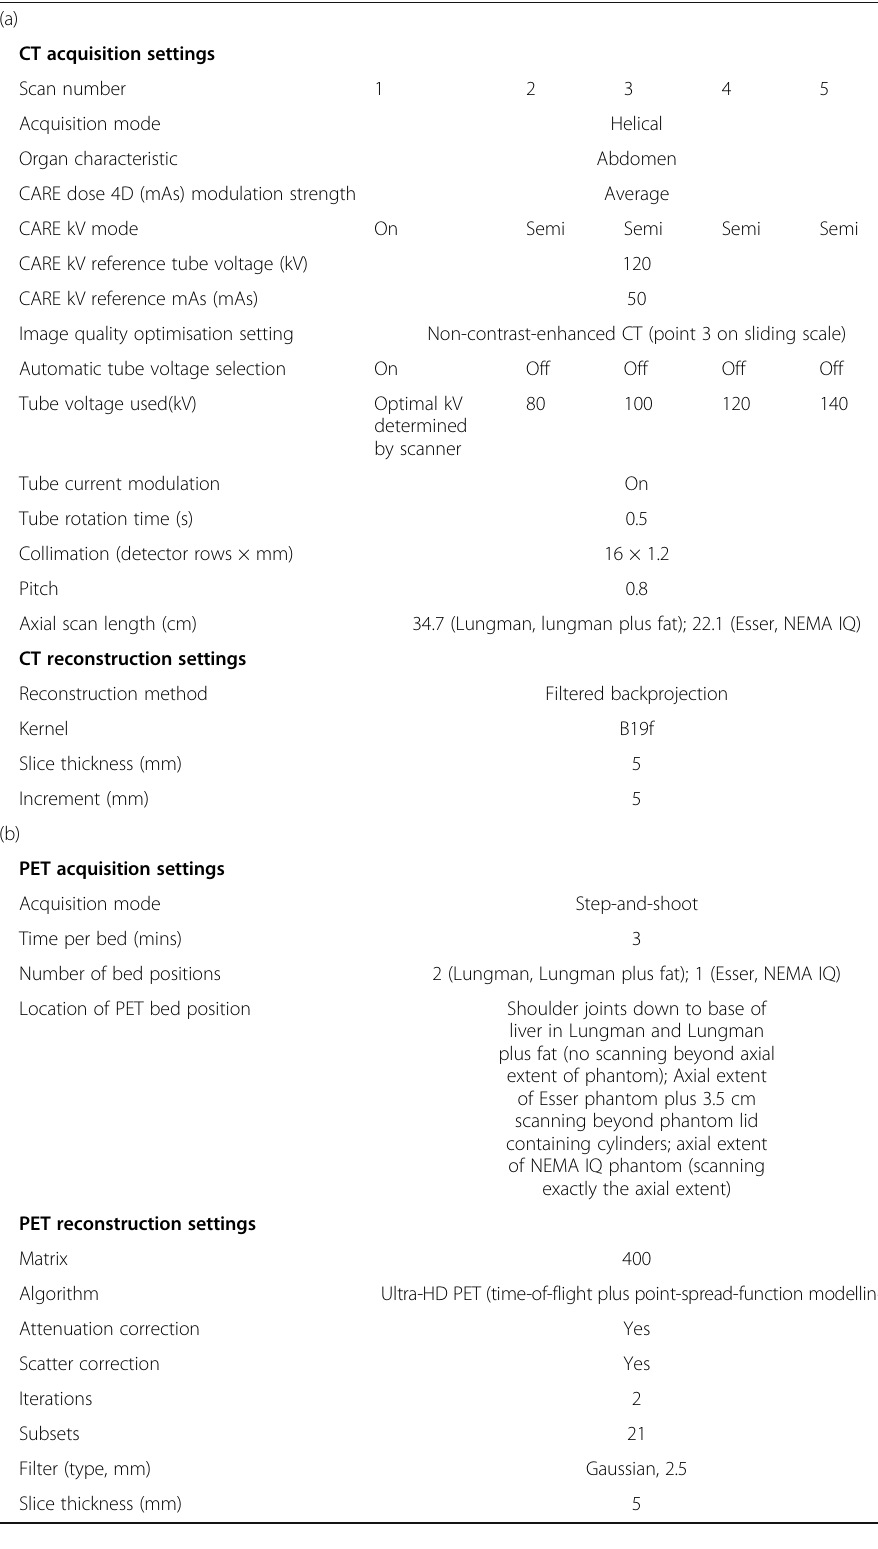
Table 1 (a) CT and (b) PET acquisition and reconstruction protocol settings for the phantom scans